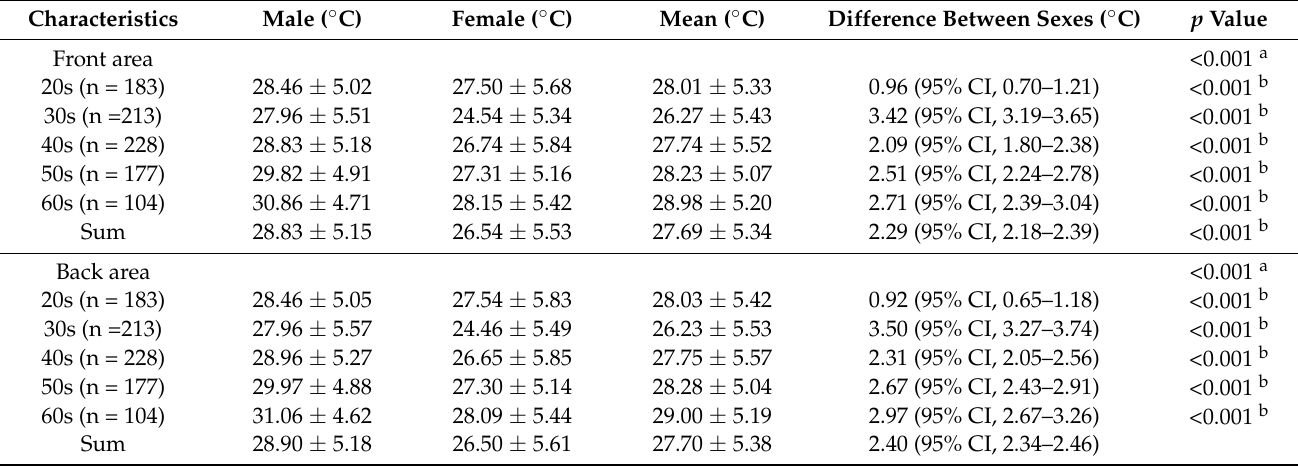
Table 5. Comparison of mean temperature for the same region of interest according to sex and age group.